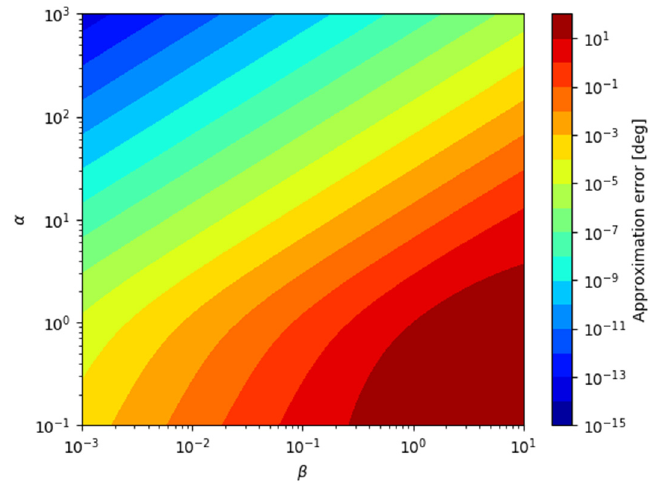
Figure 2. Approximation error ε ( α , β ) (Log-scale).